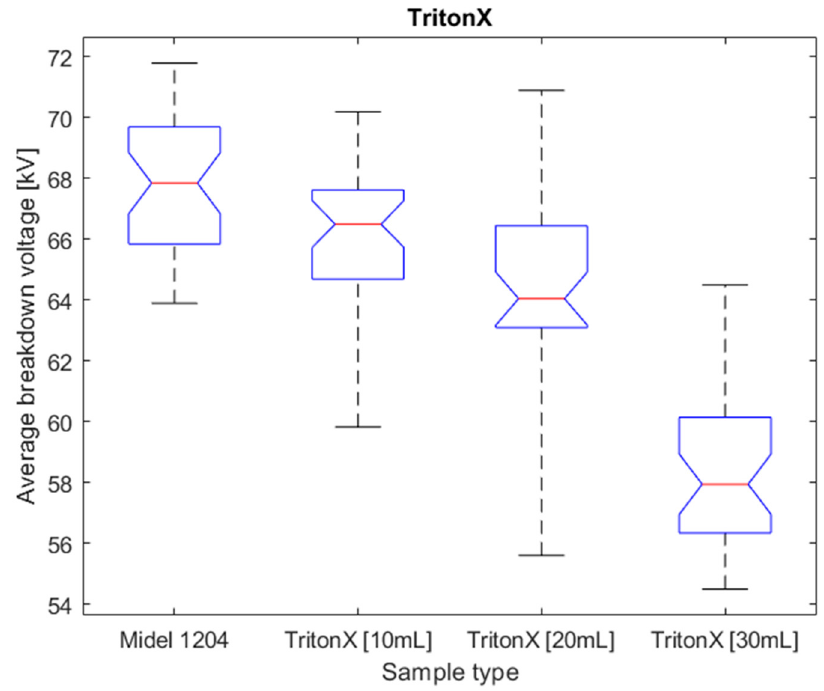
Figure 12. Box plot for surfactant population of Triton X.